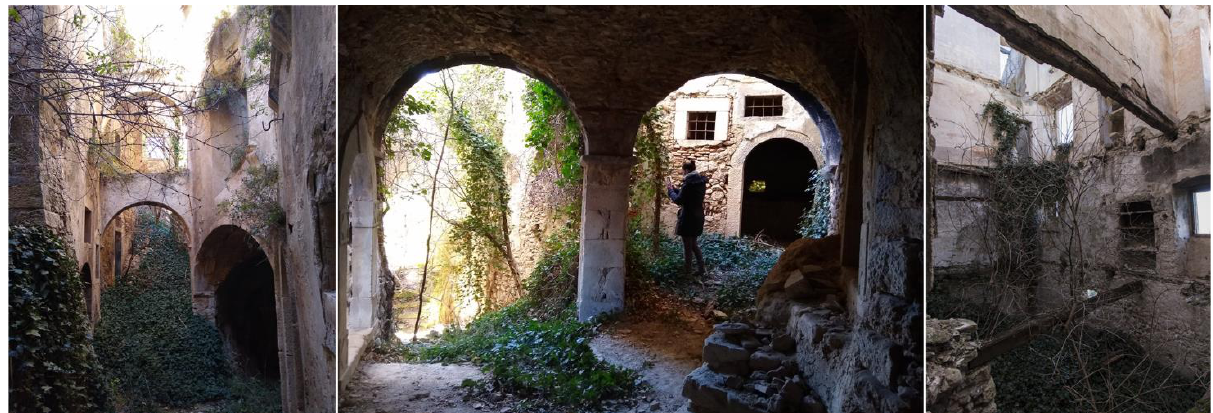
Figure 3. Views from the on-site visit to the case study